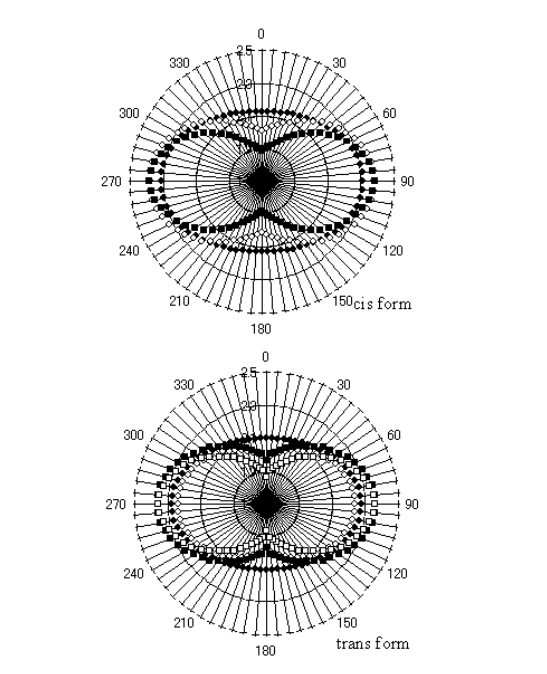
Figure 12. Circular diagram for PMMA-DR1 n  - ϖ * at 493 nm for [above] cis form and [below] trans form (symbols as in Fig.